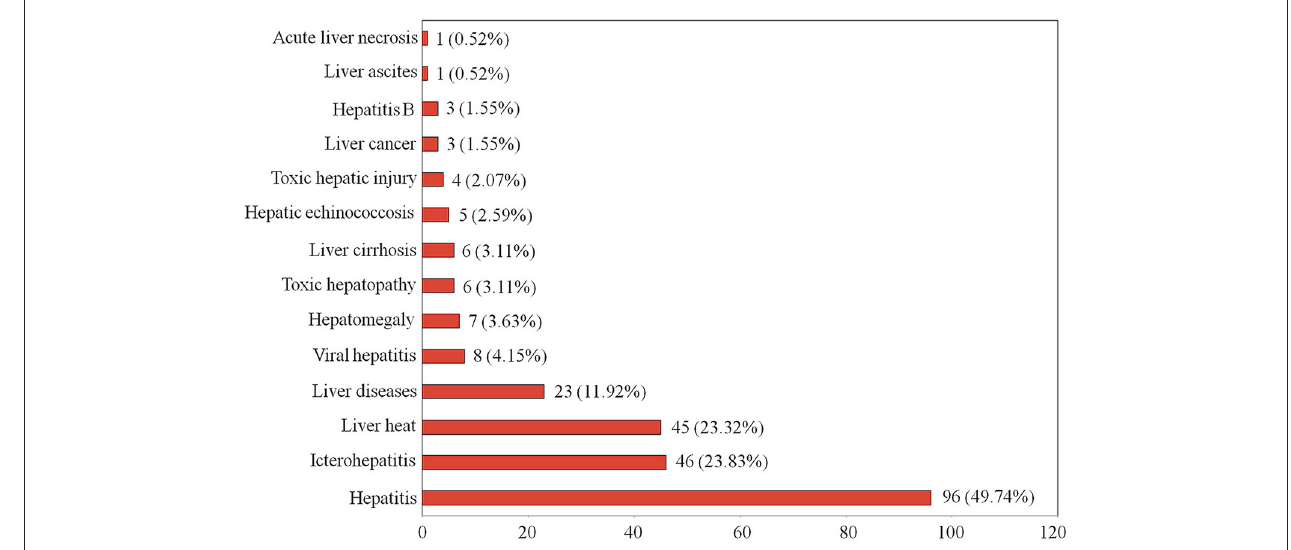
FIGURE 1 | The number and percentage of traditional Tibetan medicines used in the treatment of various liver diseases.